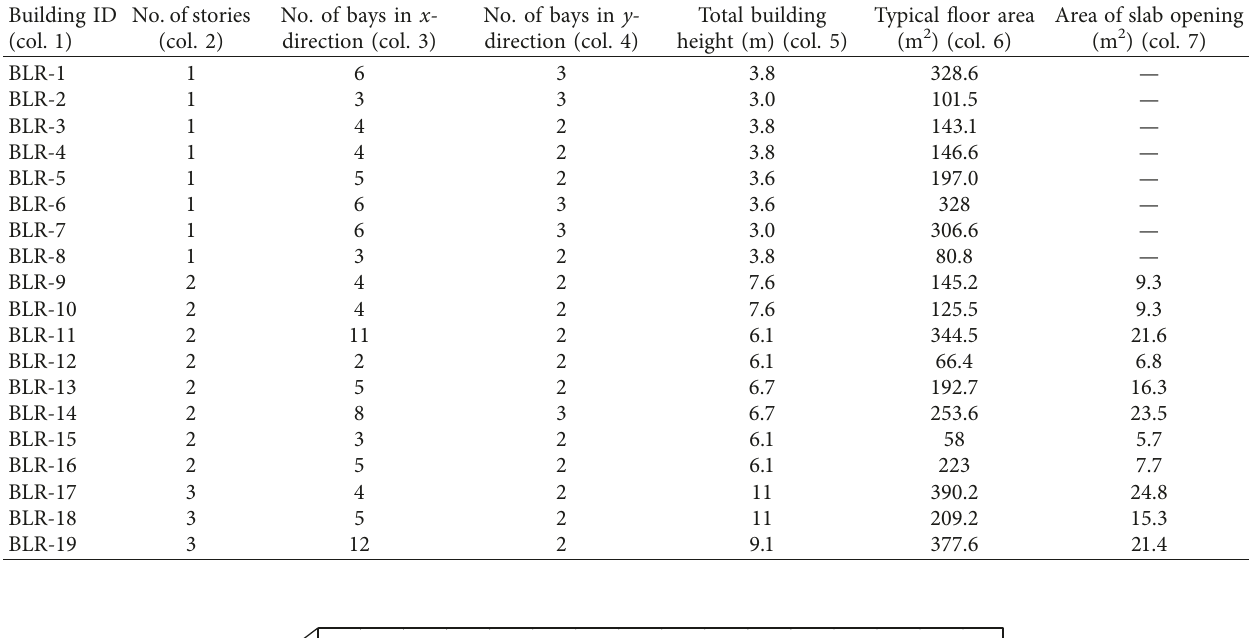
Table 1: General properties of the buildings in developed database.